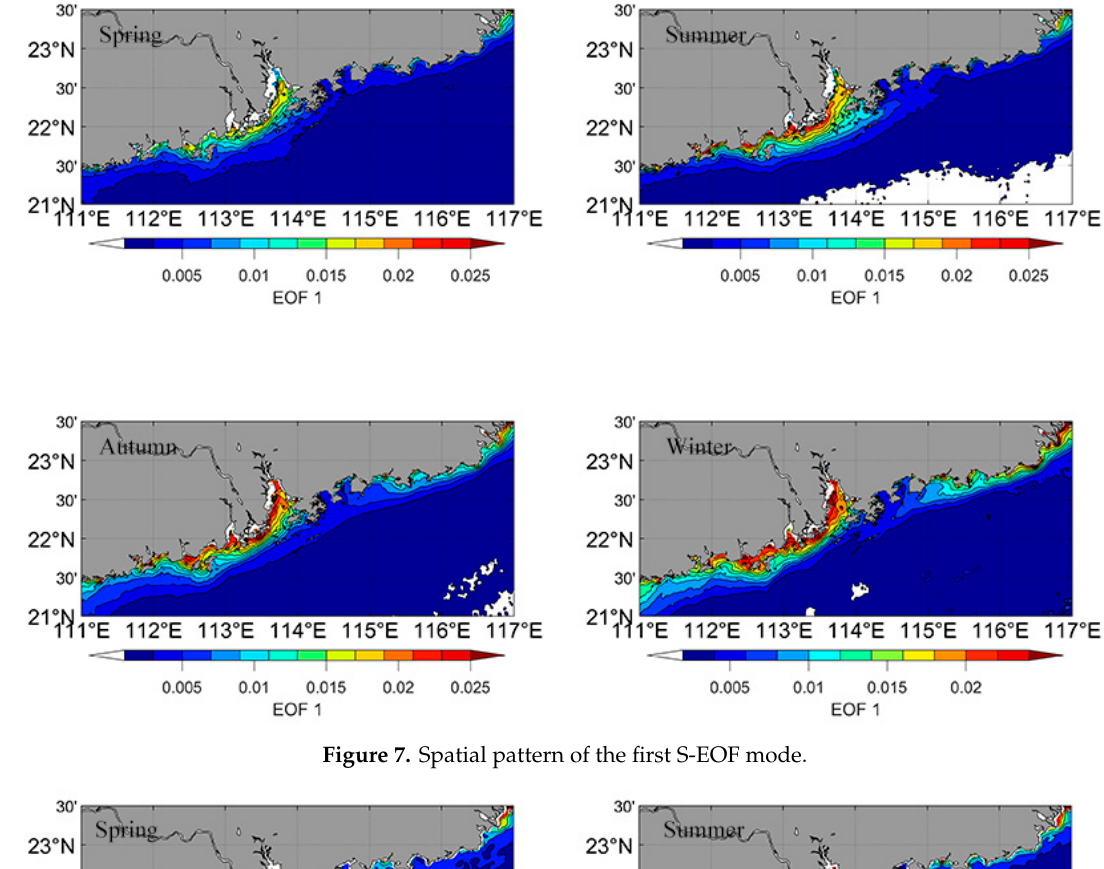
Figure 7. Spatial pattern of the first S-EOF mode.